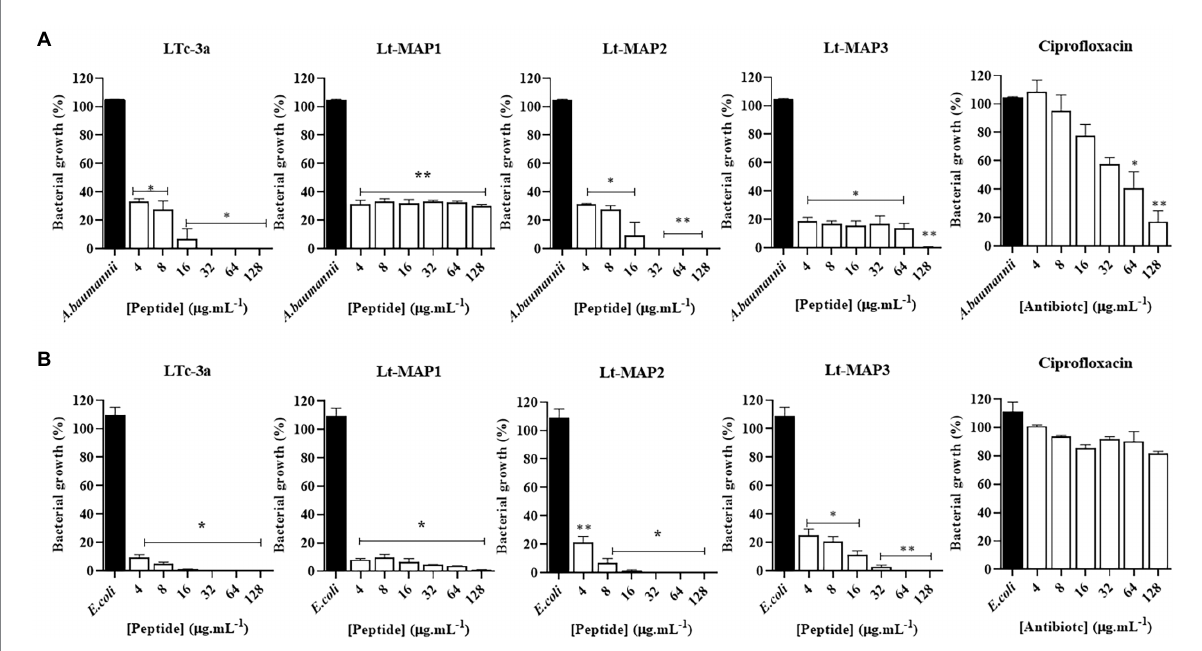
FIGURE 3 Antibiofilm activity of Ltc-3a peptides and their analogs, Lt-MAP1, Lt-MAP2, and Lt-MAP3 at 128–4 μ g.ml − 1 concentrations. (A) Acinetobacter baumannii —ATCC; (B) Escherichia coli —ATCC. Values are means ± Phase Dispersion Minimization of three repetitions. *symbol is statistically significant. (*) p > 0.01 and (**) p >